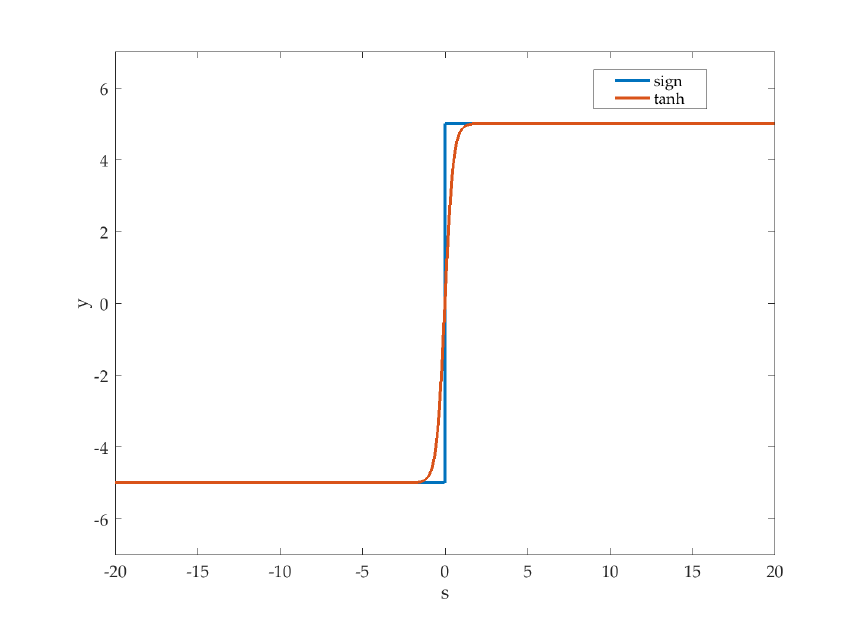
Figure 6. Time response of the hyperbolic tangent function.